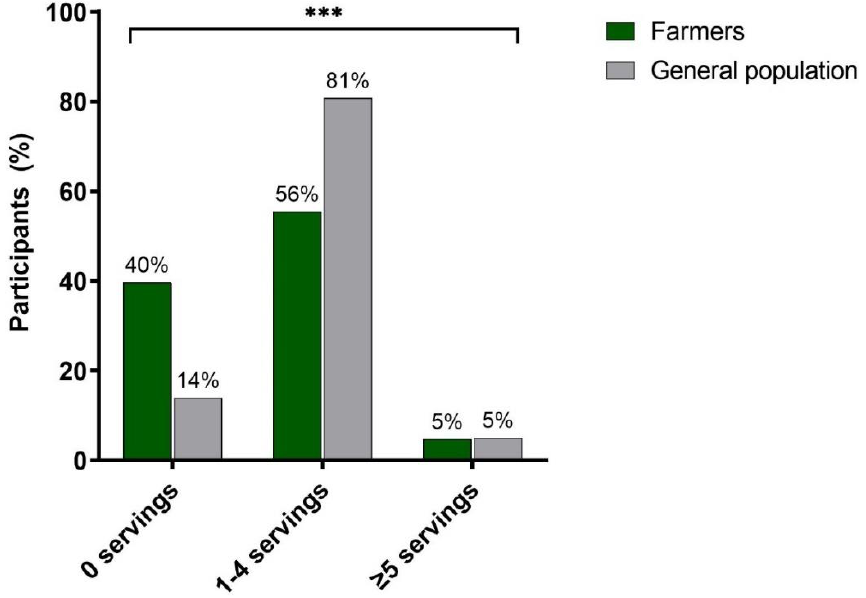
Figure 1. Participants’ percentage of daily intake of fruit & vegetables. Notes: *** significant differences between groups, which were calculated using Chi-Square Test.